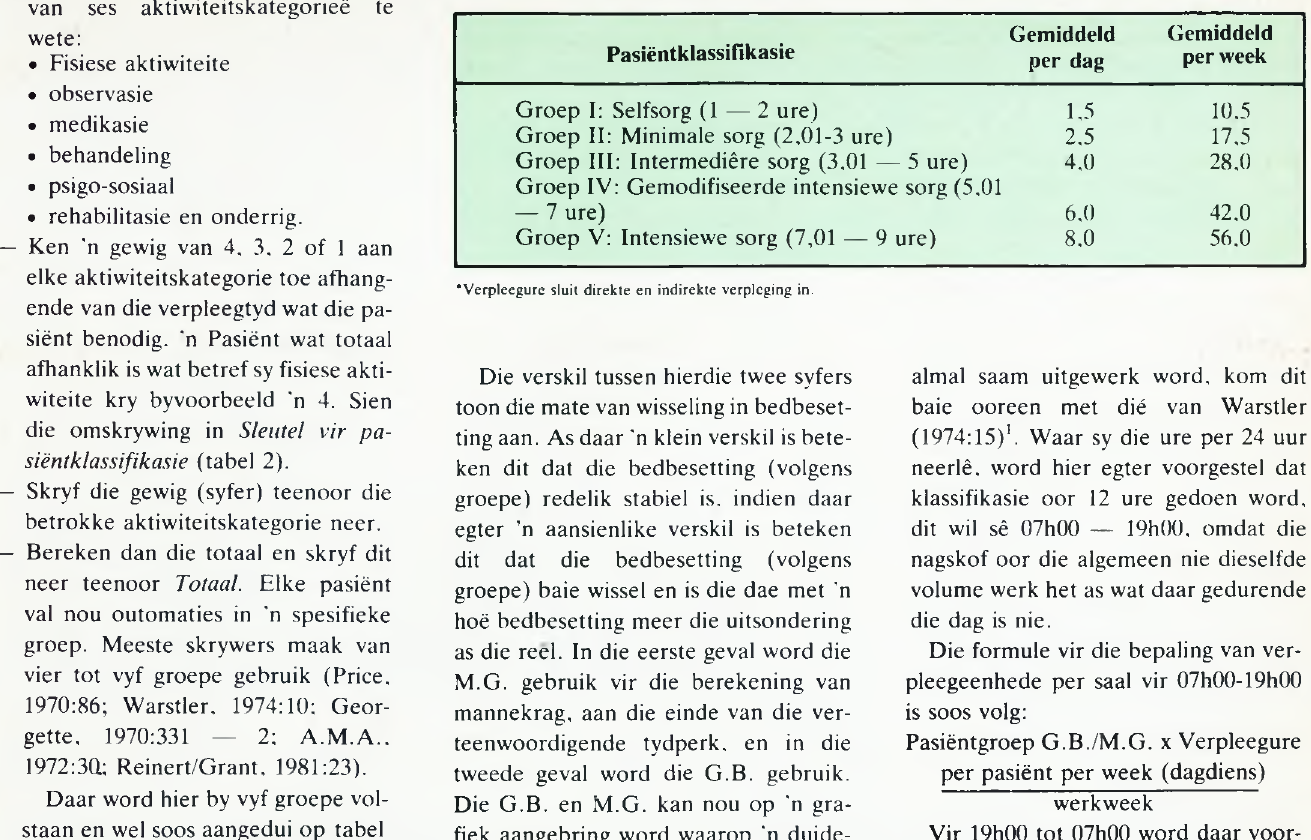
Gemiddeld Gemiddeld per week per dag